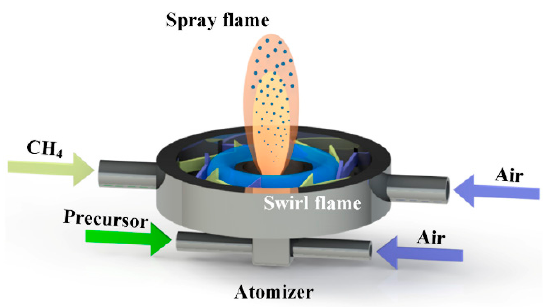
Figure 1. Schematic diagram of the swirl flame assisted gas-phase synthesis method.